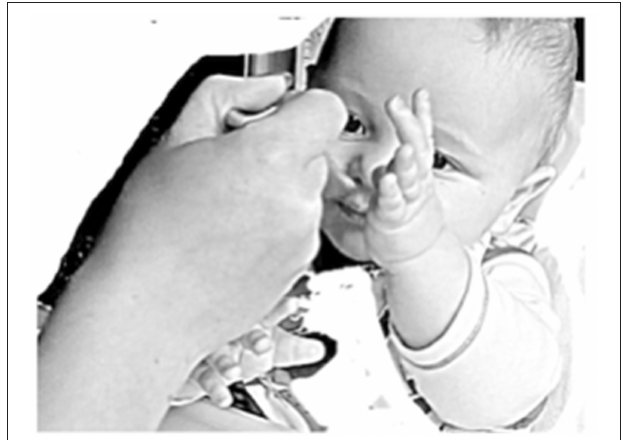
FIGURE 3 | Image published with the written informed consent of the parents of the depicted